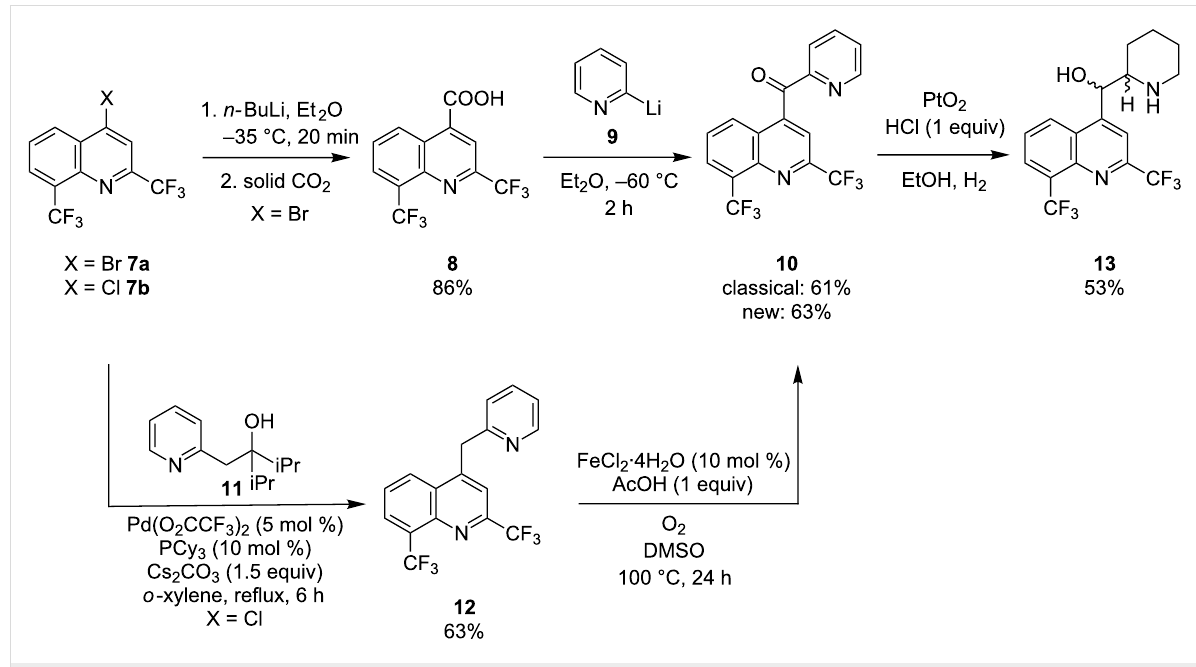
Scheme 2: Classical (top) and new formal (bottom) synthesis of